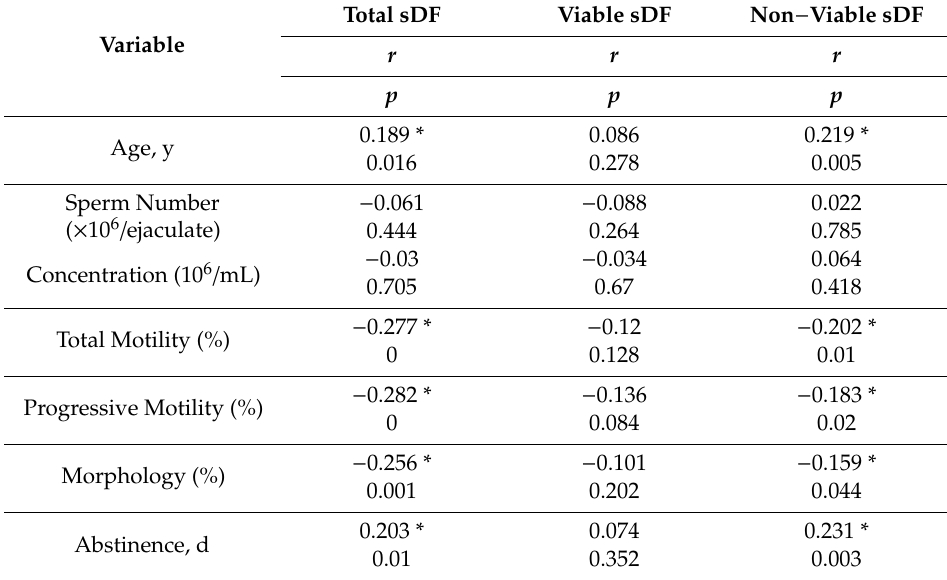
Table 2. Correlation analysis between sDF parameters and age, abstinence, and semen parameters in the recruited subjects (n = 162).